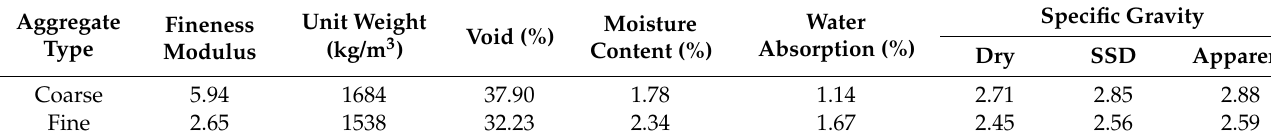
Table 2. Physical characteristics of aggregates.